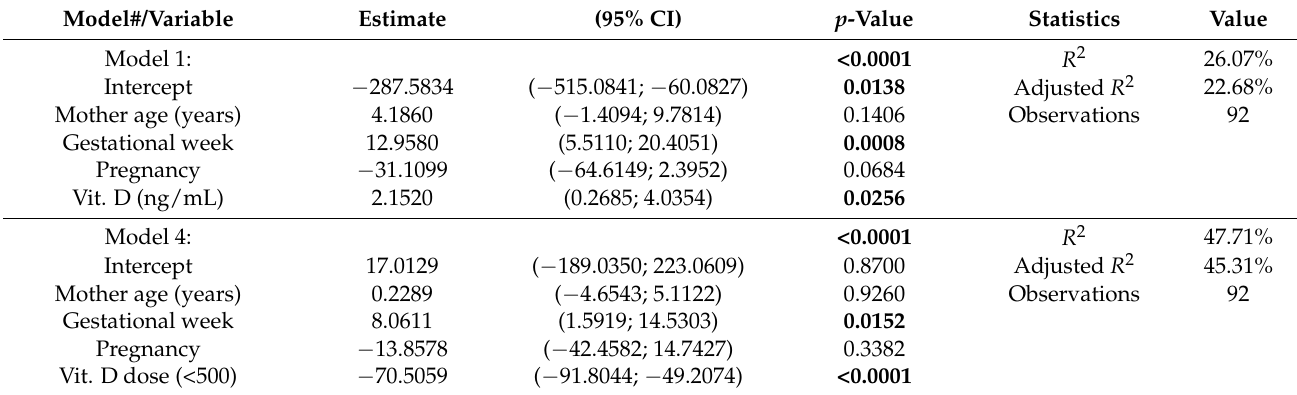
Table 3. Summary of the influence of vitamin D levels and doses on fetal weight.